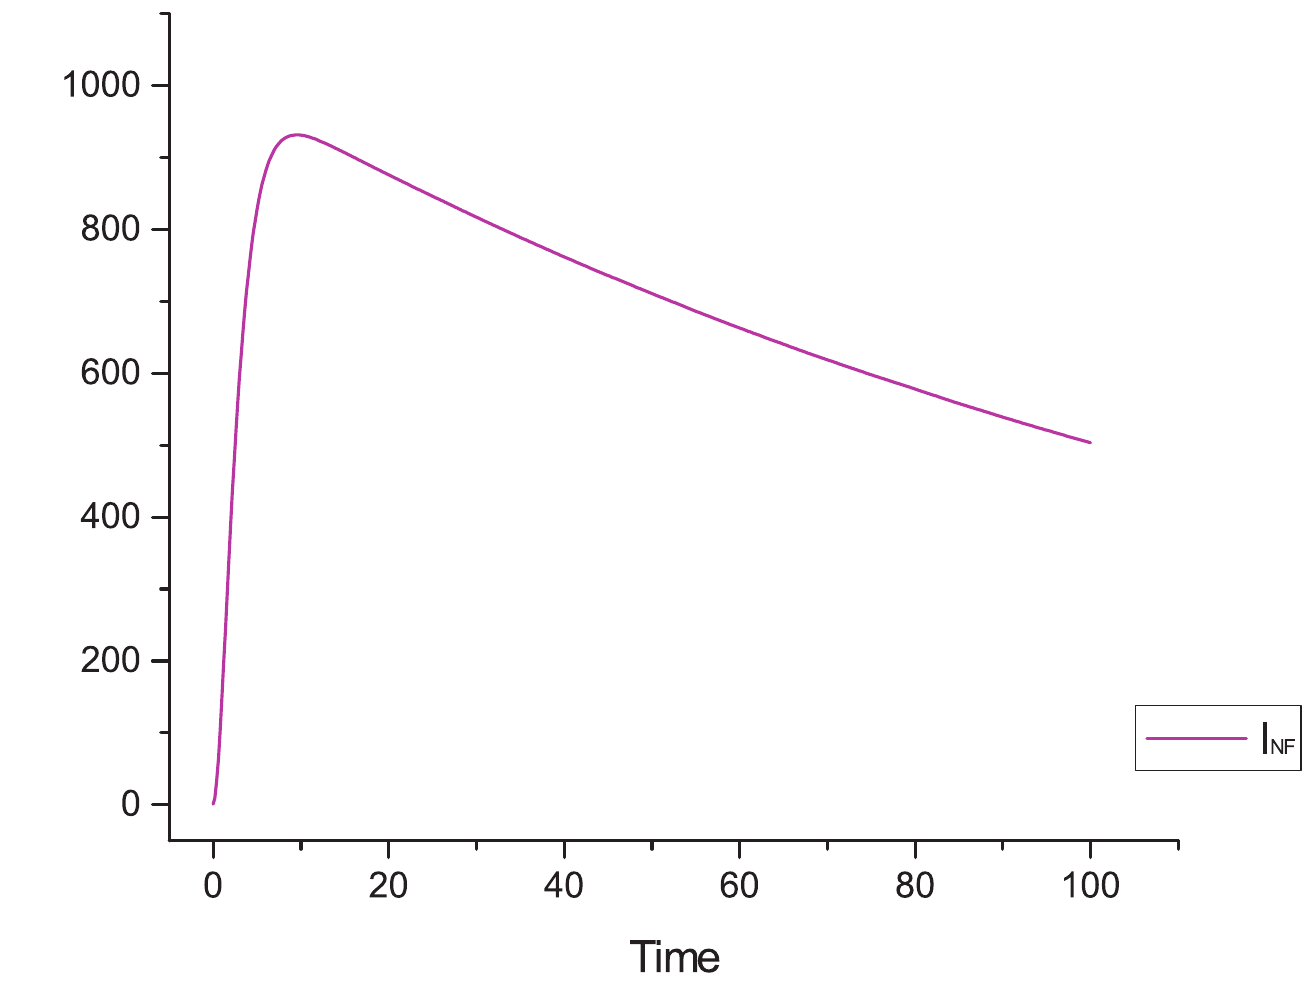
Fig 12. Behaviour of infectious compartment when infection rate is greater than the recovery